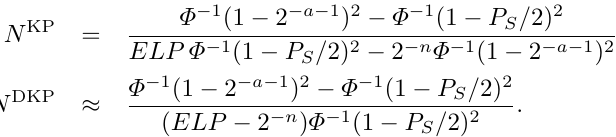
= 2 − 4 and σ 2 = 2 − 3 R W